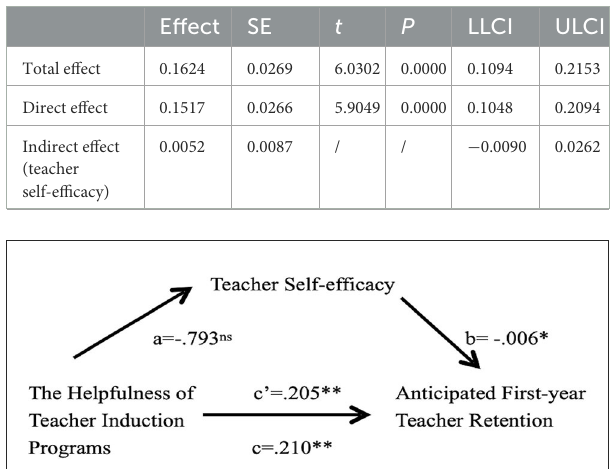
FIGURE1 Path diagram with unstandardized coefficients. * p < 0.05; ** p < 0.01; ns means not